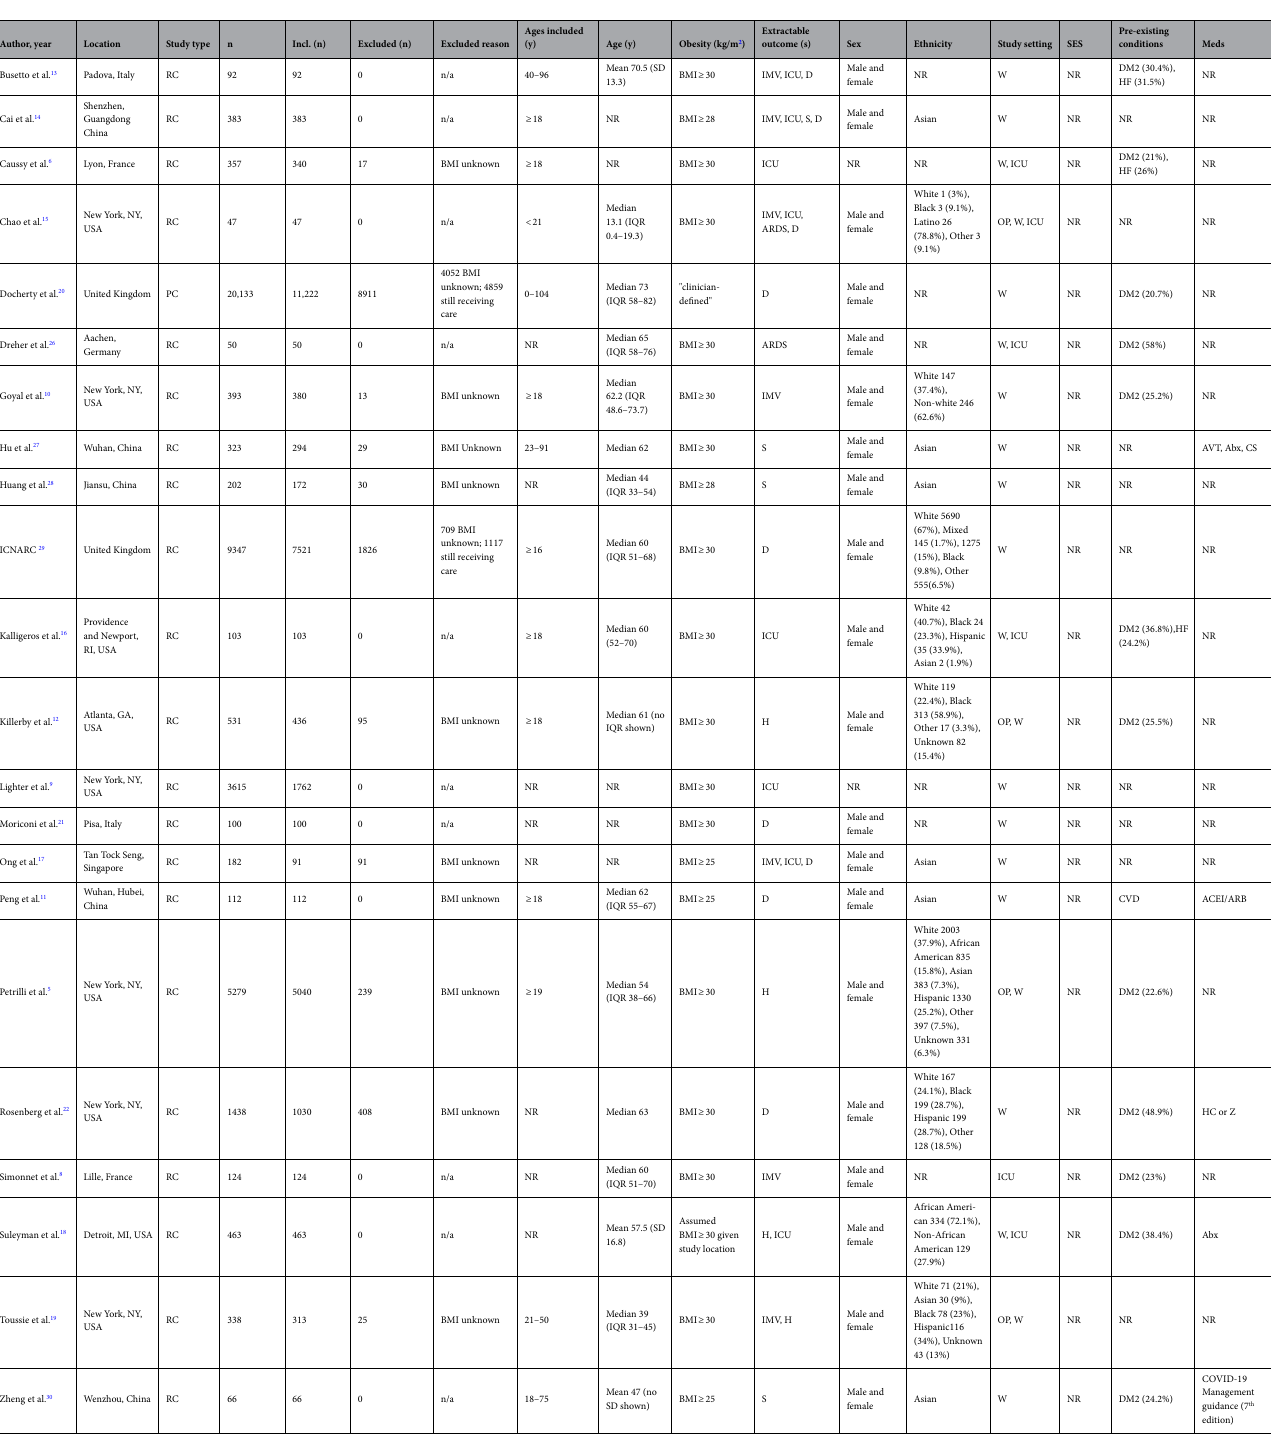
Table 1. Study characteristics. RC, retrospective cohort; PC, prospective cohort; n/a, not applicable; Incl., included; BMI, body mass index; y, years; NR, not reported; IQR, interquartile range; SD, standard deviation; S, severity; ARDS, acute respiratory distress syndrome; H, hospitalization; W, ward; OP, outpatient; ICU, intensive care unit admission; IMV, invasive mechanical ventilation; D, death; N, none; HF, heart failure; DM2, type 2 diabetes mellitus; CVD, cardiovascular disease; Meds, medications; Abx, antibiotics; AVT, antiviral therapy; HC, hydroxychloroquine; Z, azithromycin; CS, corticosteroids; ACEi, angiotensin converting enzyme II inhibitor; ARB, angiotensin II receptor